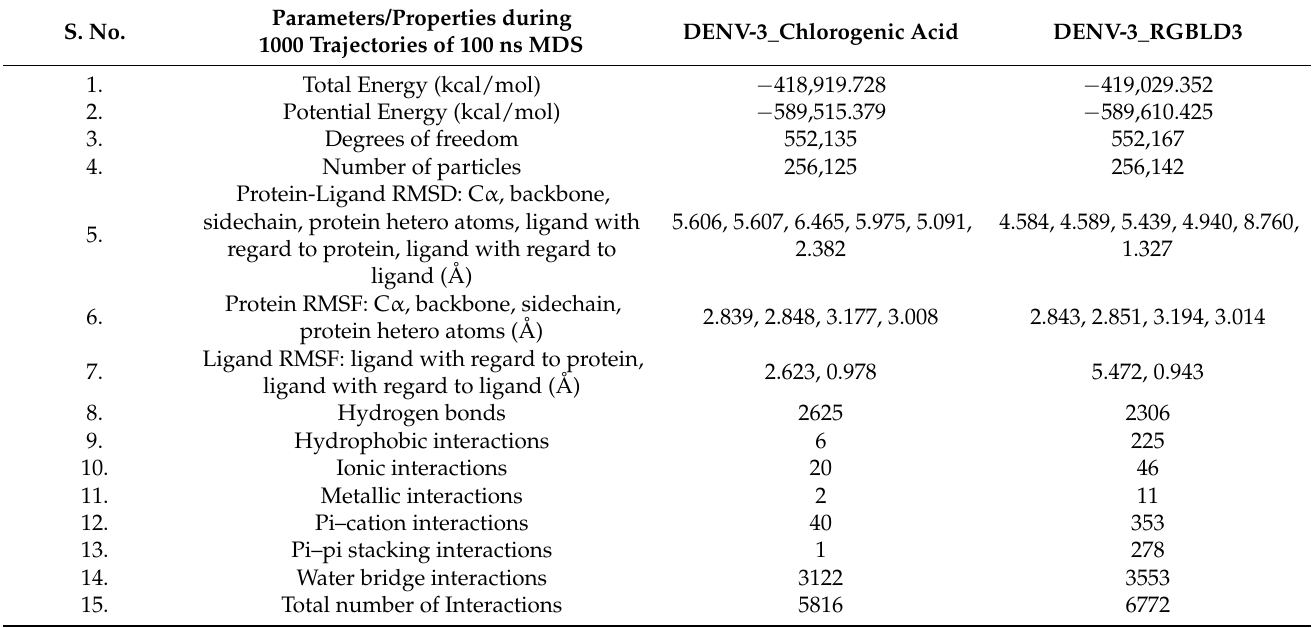
Table 8. Comparison of scores obtained in the molecular dynamic’s simulation parameters for DENV-3 reference molecule and novel analog molecule.